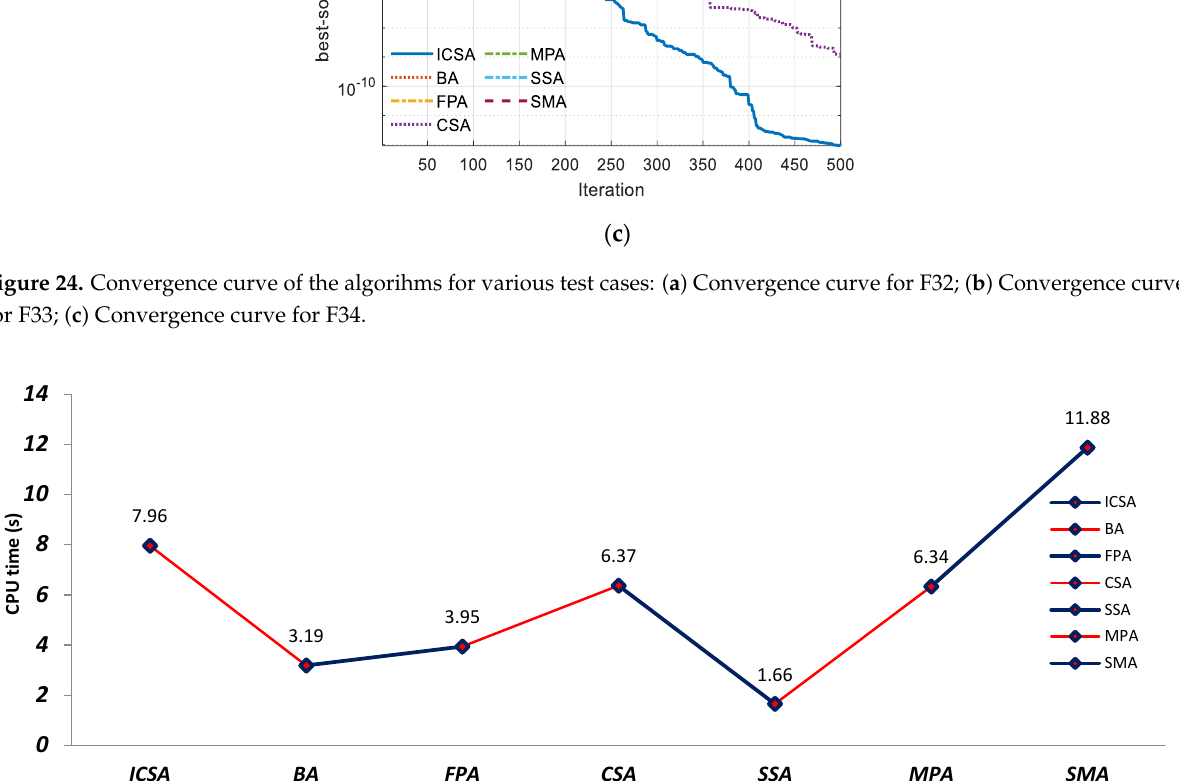
( c ) Figure 26. Boxplot of CSA and ICSA for various test cases : ( a ) Boxplot for F1; ( b ) Boxplot for F2; ( c ) Boxplot for F3.